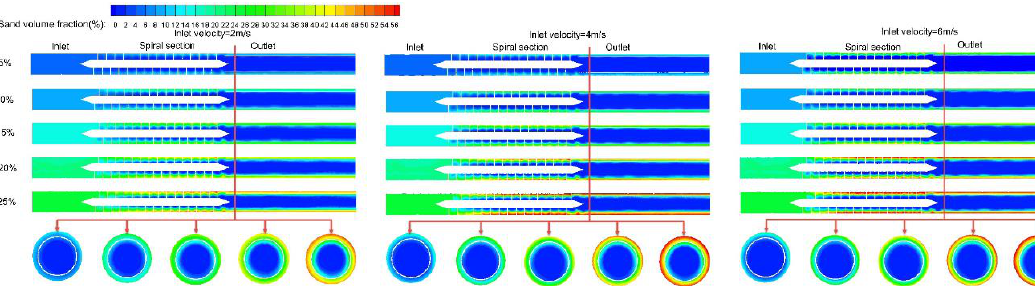
Figure 12. Sand distribution contours across the horizontal section of the spiral separator and the vertical section at the outlet with different inlet sand volume fraction.